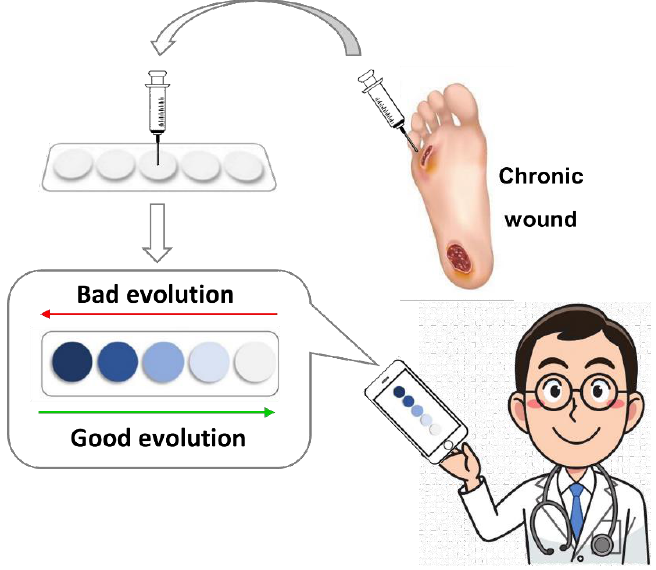
Figure 17. Scheme of the ninhydrin-based sensor for monitoring chronic human wounds’ evolution with a smartphone ’ s assistance.